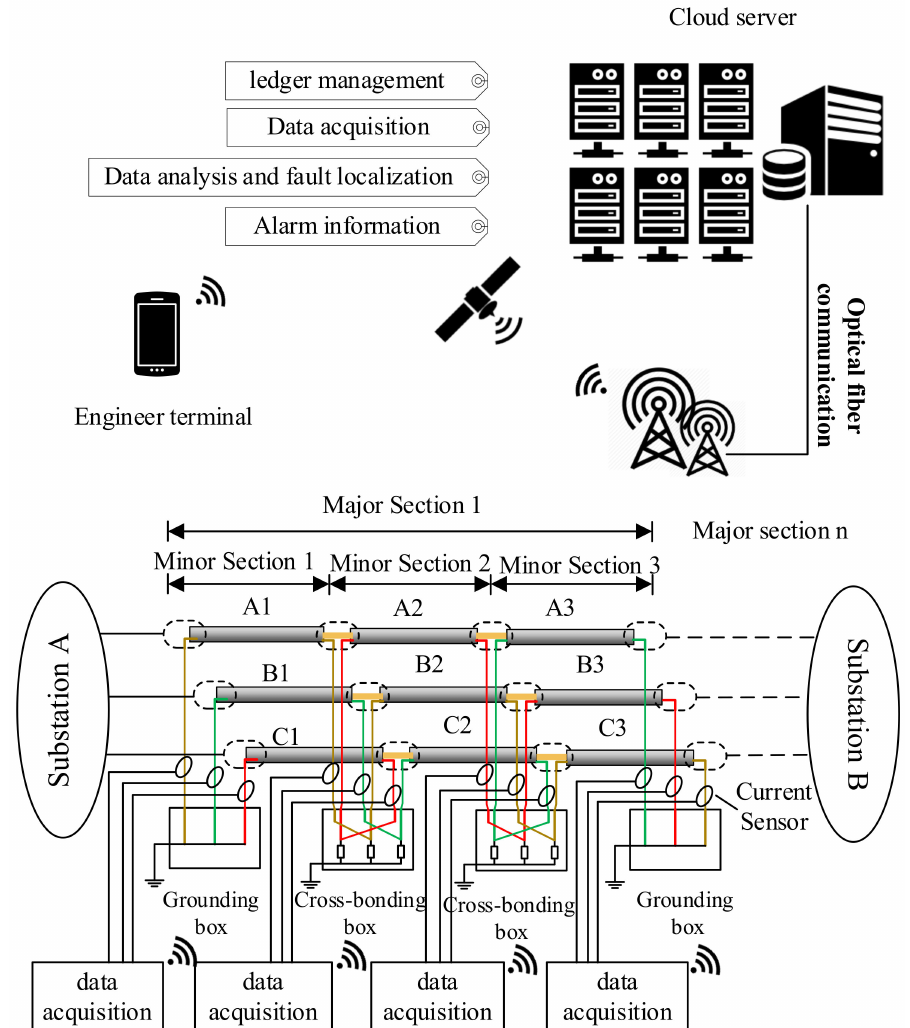
Figure 2. The designed sheath currents monitoring system (The yellow line represents phase A, the green line represents phase B, the red line represents phase C. A1–C3 are the labels of different cable